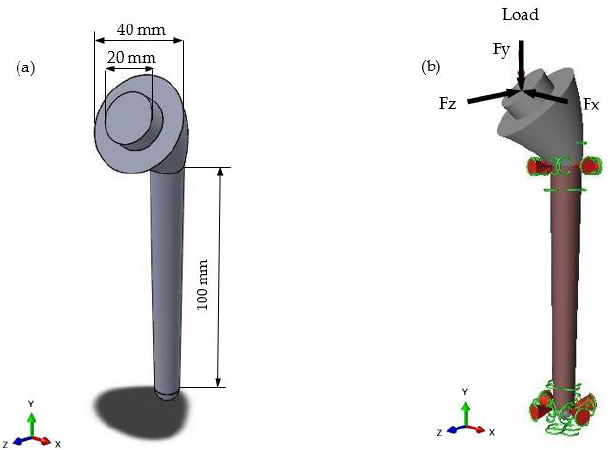
Figure 1. ( a ) CAD geometry of humeral implant stem design created in Solidworks 2018; ( b ) implant geometry showing applied load and supports. Highlighted area represents the design space. Markers at the base and neck represent the supports. Arrow at the head represents